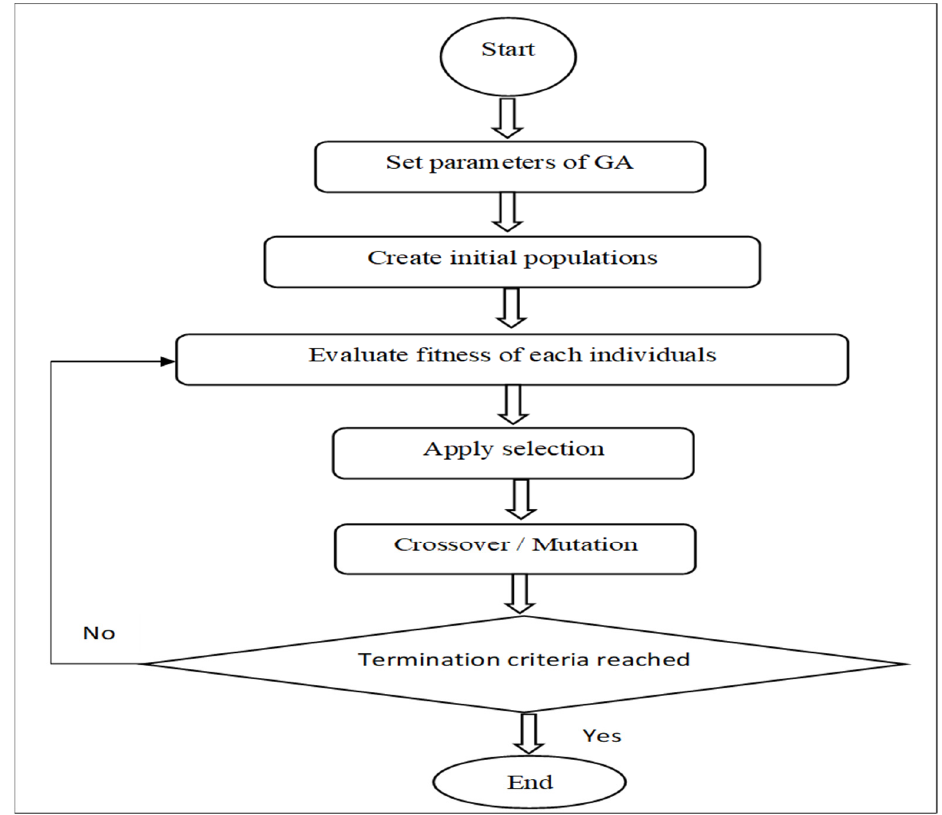
Figure 2. Describes the flowchart of genetic algorithm .